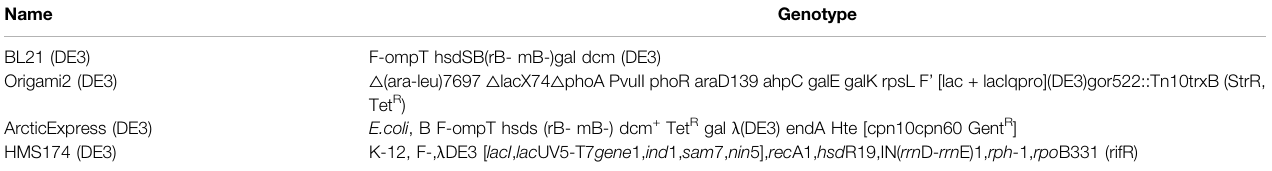
TABLE 2 | The genotypes of the four strains used in this study.